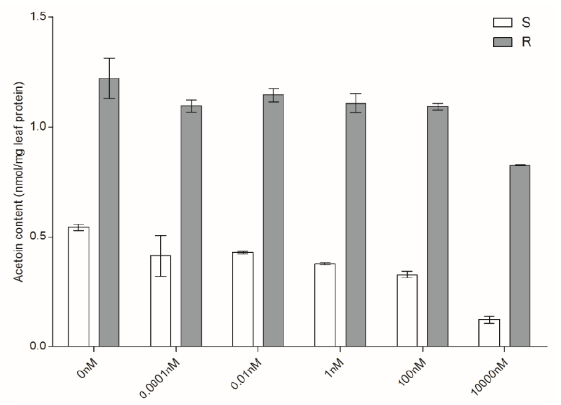
Figure 3. The ALS activity of S and R with various concentrations of metsulfuron-methyl. The x -axis represents different doses of metsulfuron-methyl. Bars are mean ± standard error (n = 3).